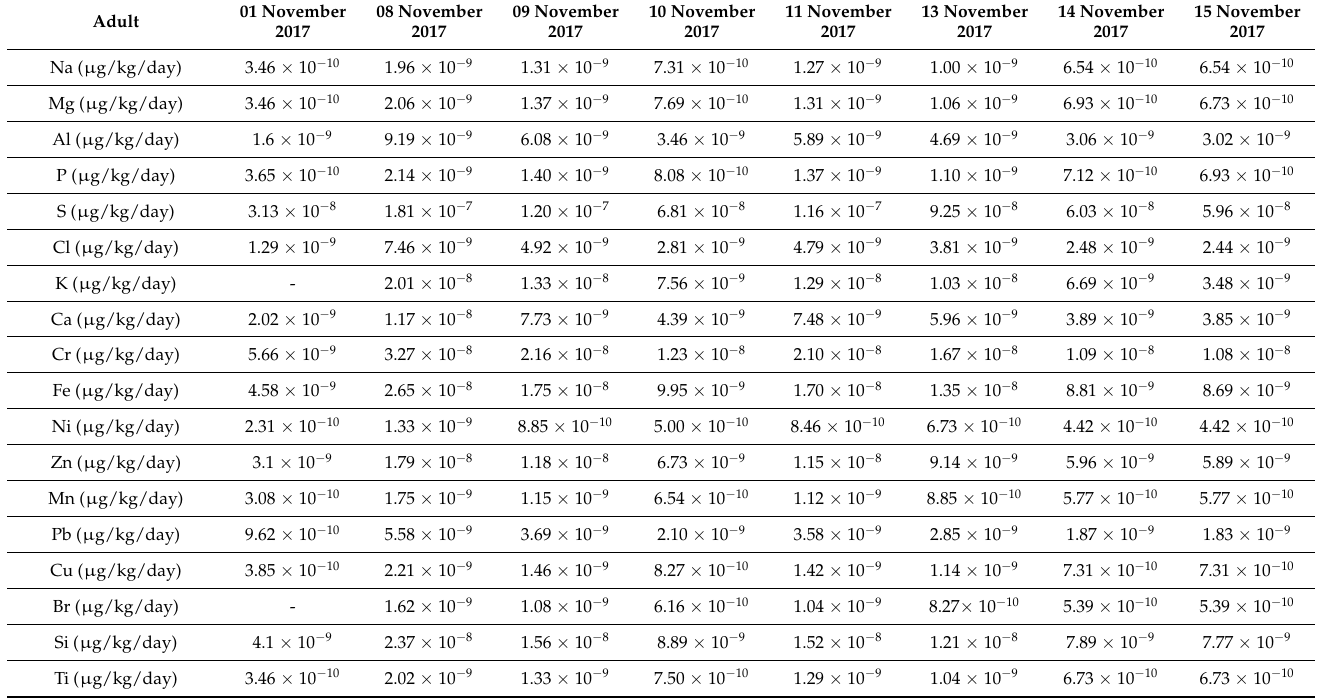
Table 8. Average daily dose ( µ g/kg/day) of different elements present in PM 2.5 for adults during different days of sampling.